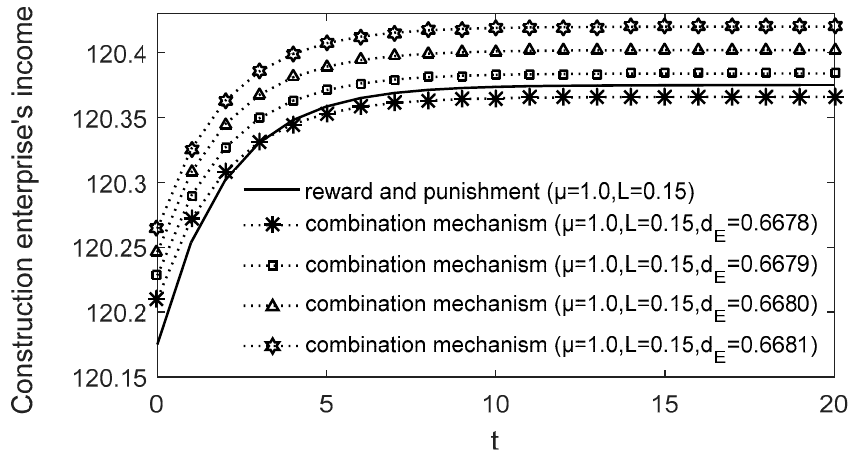
Figure 8. Construction enterprise’s income when 𝑑 (cid:3006) takes different values under the combination mechanism.